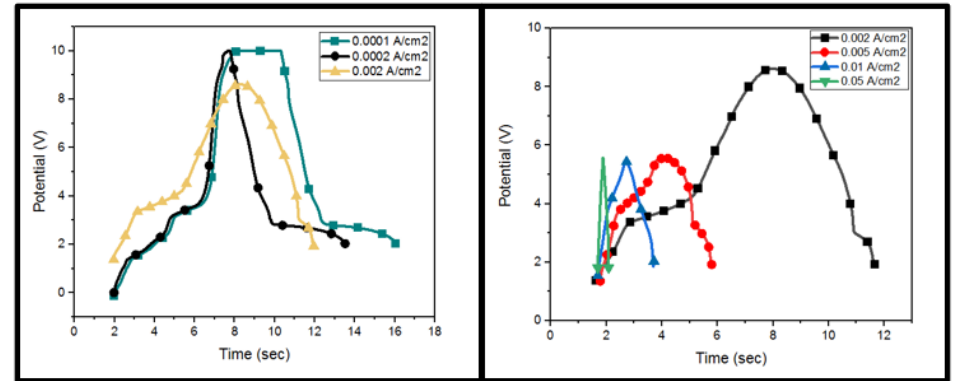
Fig. 7. Galvanostatic charge-discharge curve for the OP-LSG coated electrode